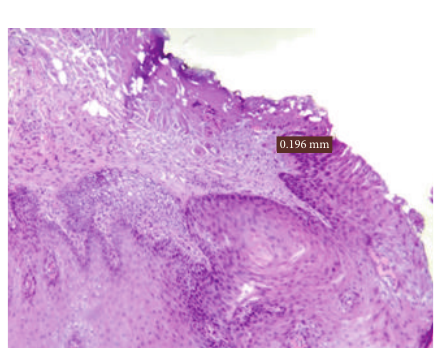
Figure 5: Damage measurement in a hyperkeratotic lesion.